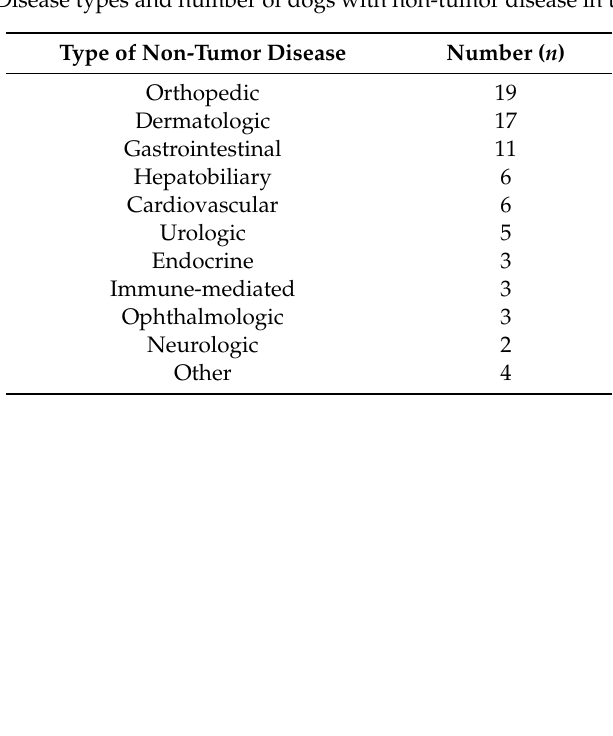
Table 2. Disease types and number of dogs with non-tumor disease in this